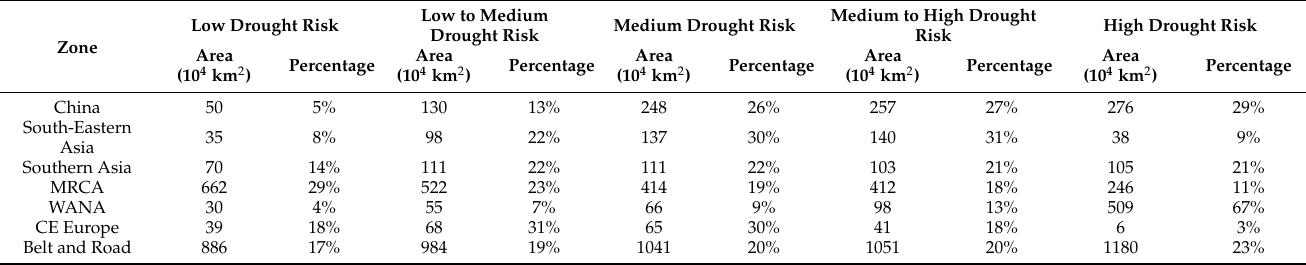
Table 3. “Belt and Road” drought impact area and proportion statistics